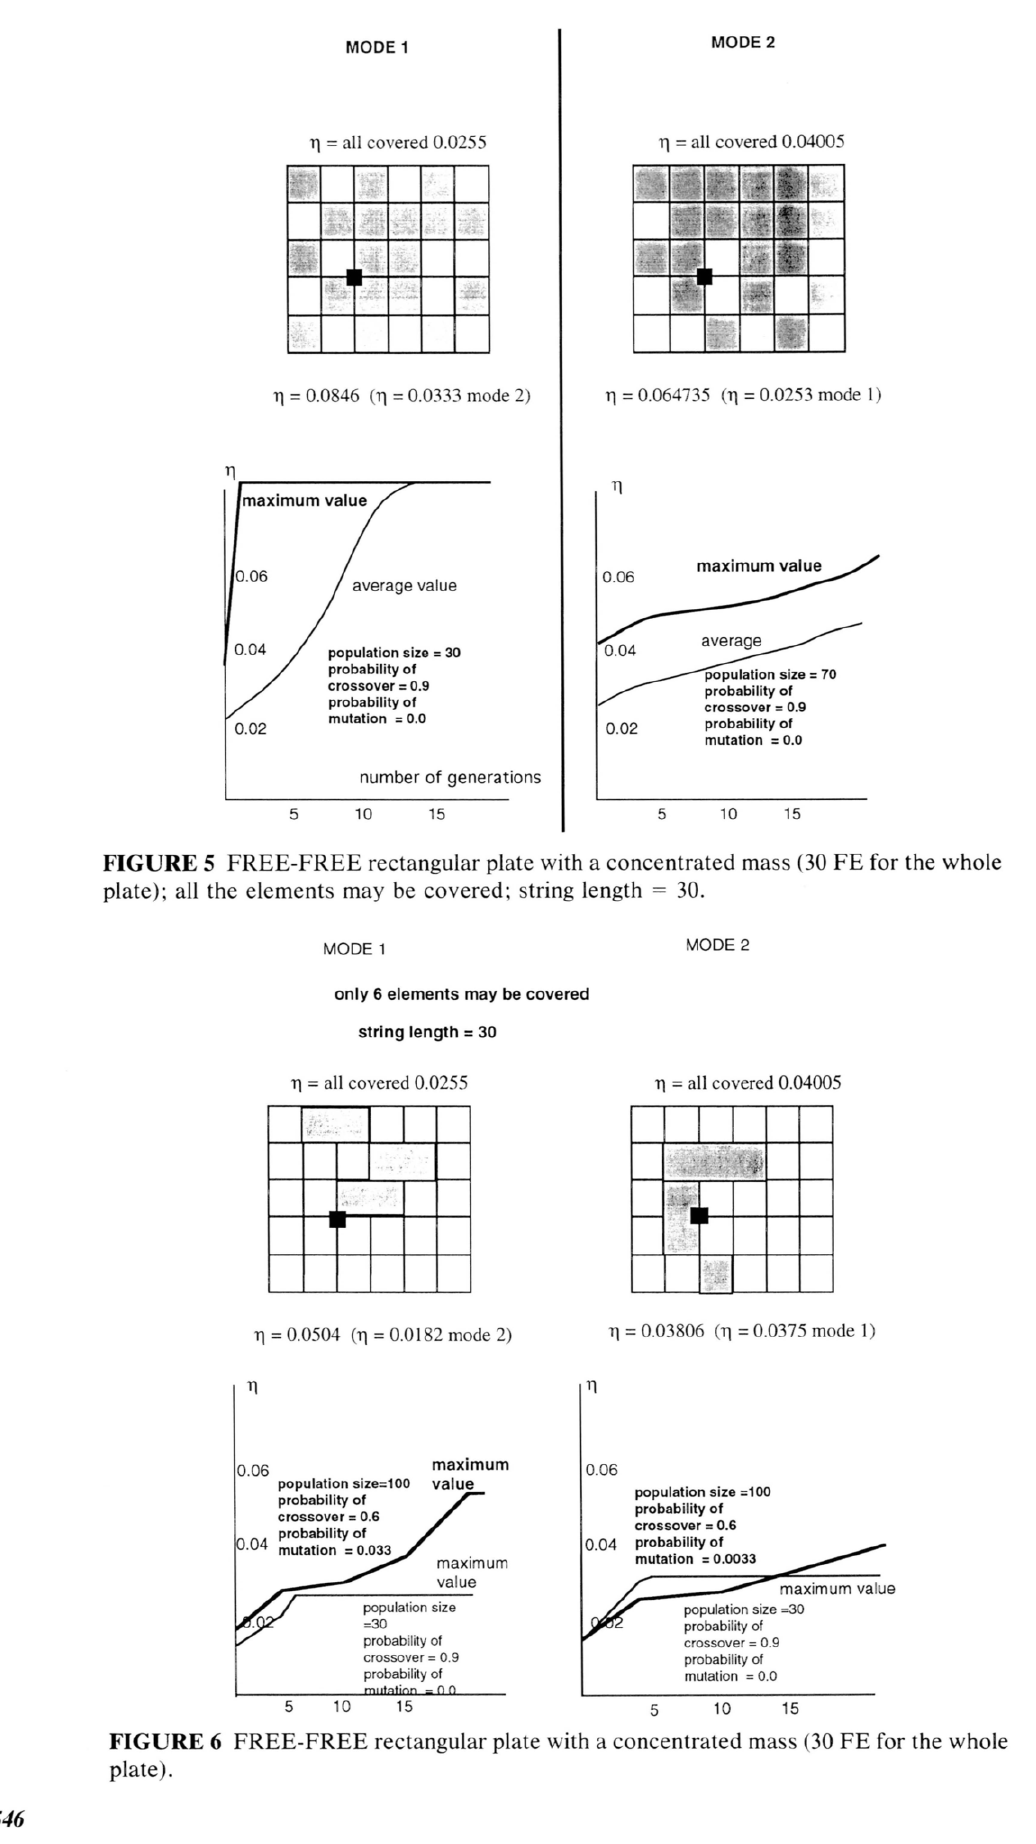
FIGURE 6 FREE-FREE rectangular plate with a concentrated mass (30 FE for the whole